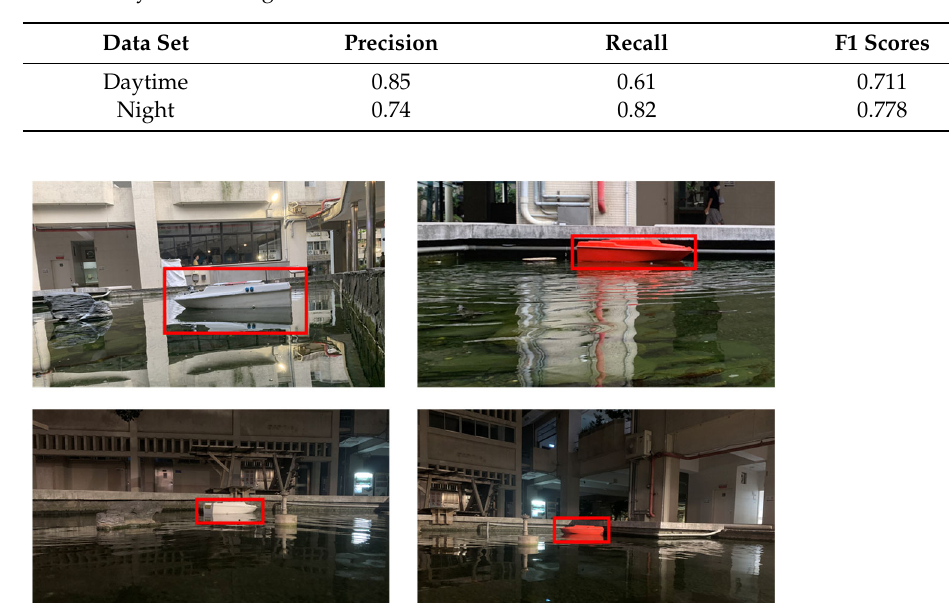
Table 4. Daytime and night data set evaluation.